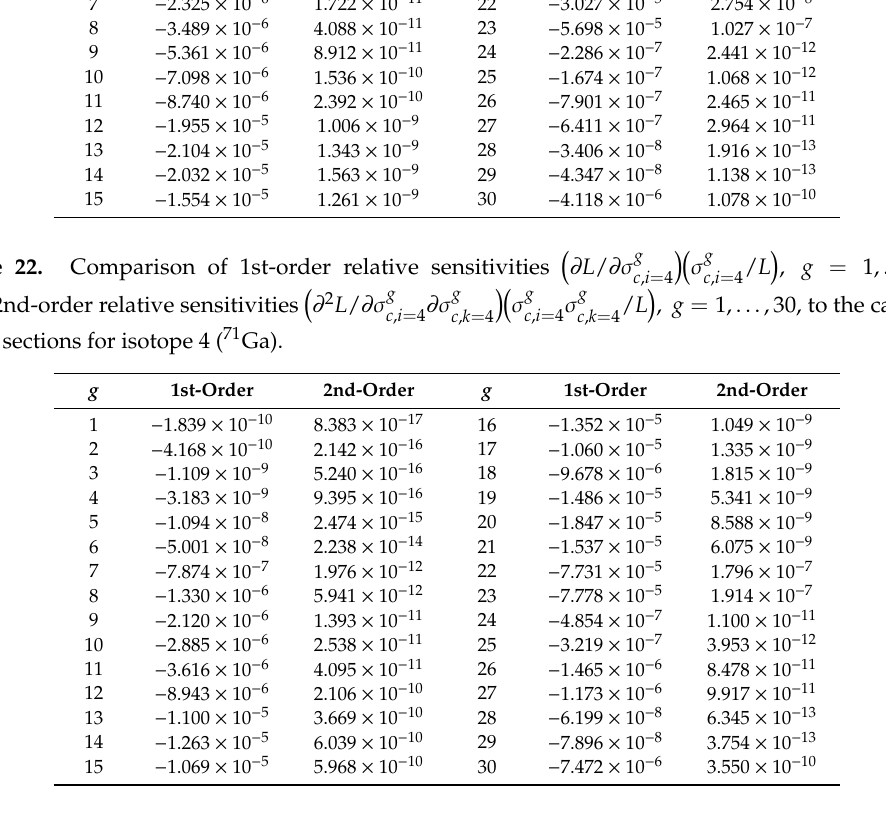
Table 21. Comparison of 1st-order relative sensitivities 2nd-order relative sensitivities sections for isotope 3 ( 69 Ga).